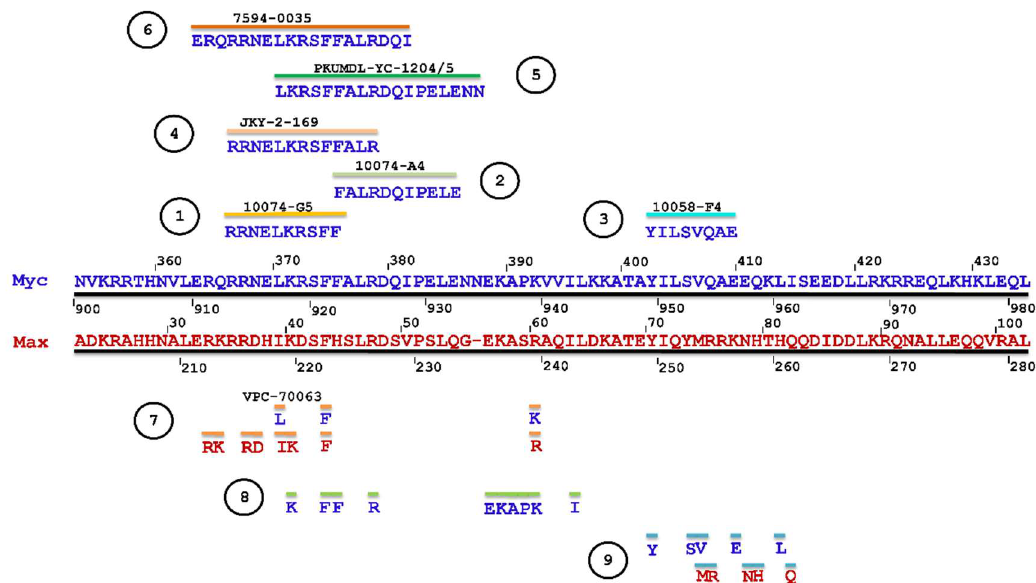
Figure 13. Binding sites for structurally diverse Myc-Max inhibitors mapped along Myc and Max protein sequences. Residue numbering above a protein sequence follows the convention for individual monomers, while that bellow follows the numbering in the Myc-Max X-ray structure. Binding sites described in the text are numbered and illustrated by circle-enclosed digits. The coloring scheme suggests three major druggable sites on Myc, both in disordered monomeric form or in the functional ordered form of the Myc-Max heterodimer.